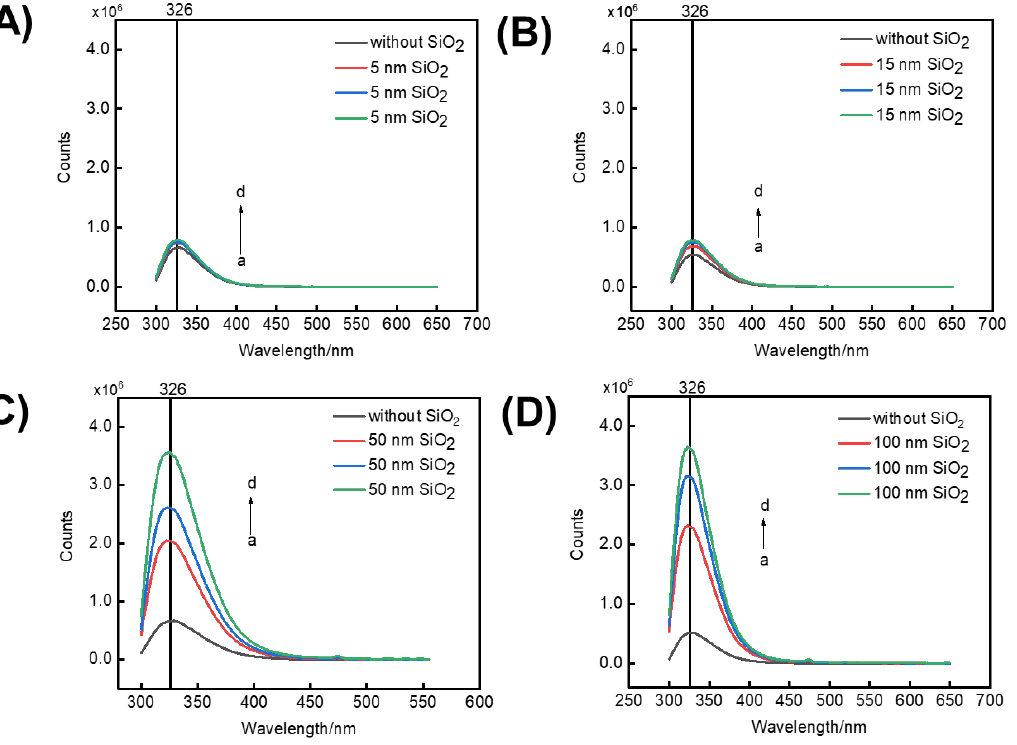
Figure 6. Fluorescence spectra of lysozyme solutions with and without SNP. ( A ) 5 nm SiO 2 ; ( B ) 15 nm SiO 2; ( C ) 50 nm SiO 2 ; ( D ) 100 nm SiO 2 . From bottom to top: a, no SNP; b, 1 mg/mL; c, 2 mg/mL; d, 3